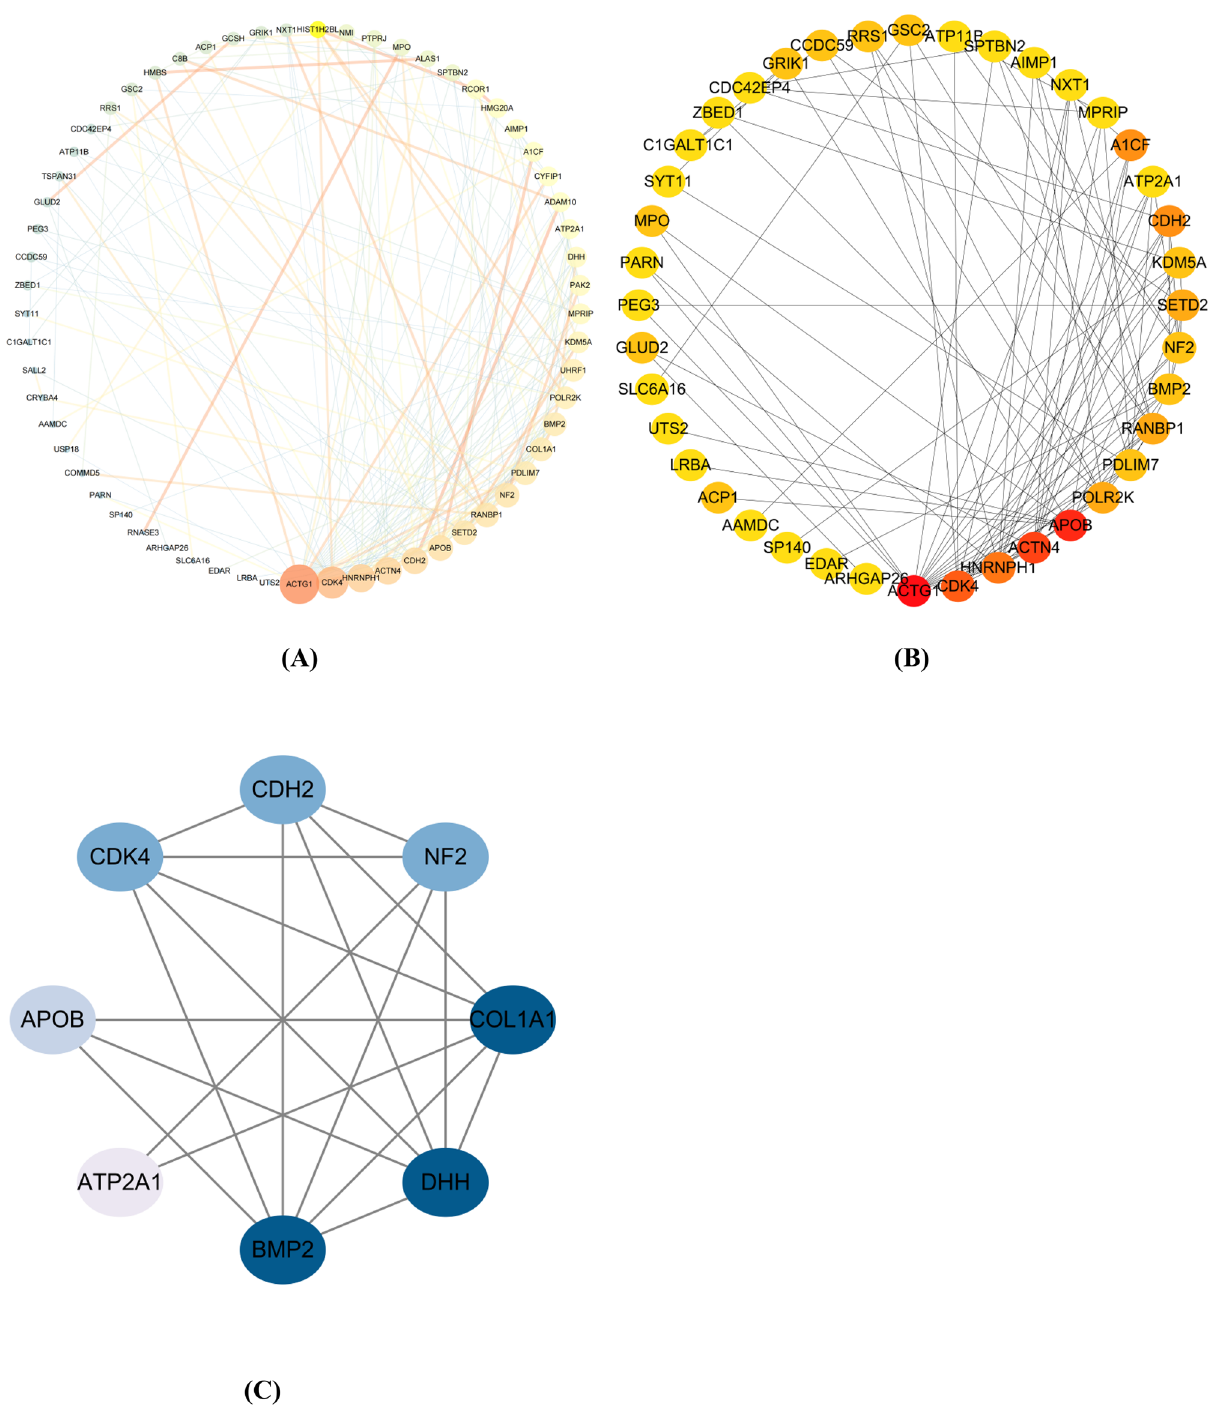
Figure 5. PPI network and module analysis. ( A ) PPI network of CNO-related genes. ( B ) The subnetwork of 40 hub CNO genes. ( C ) The key module of the PPI